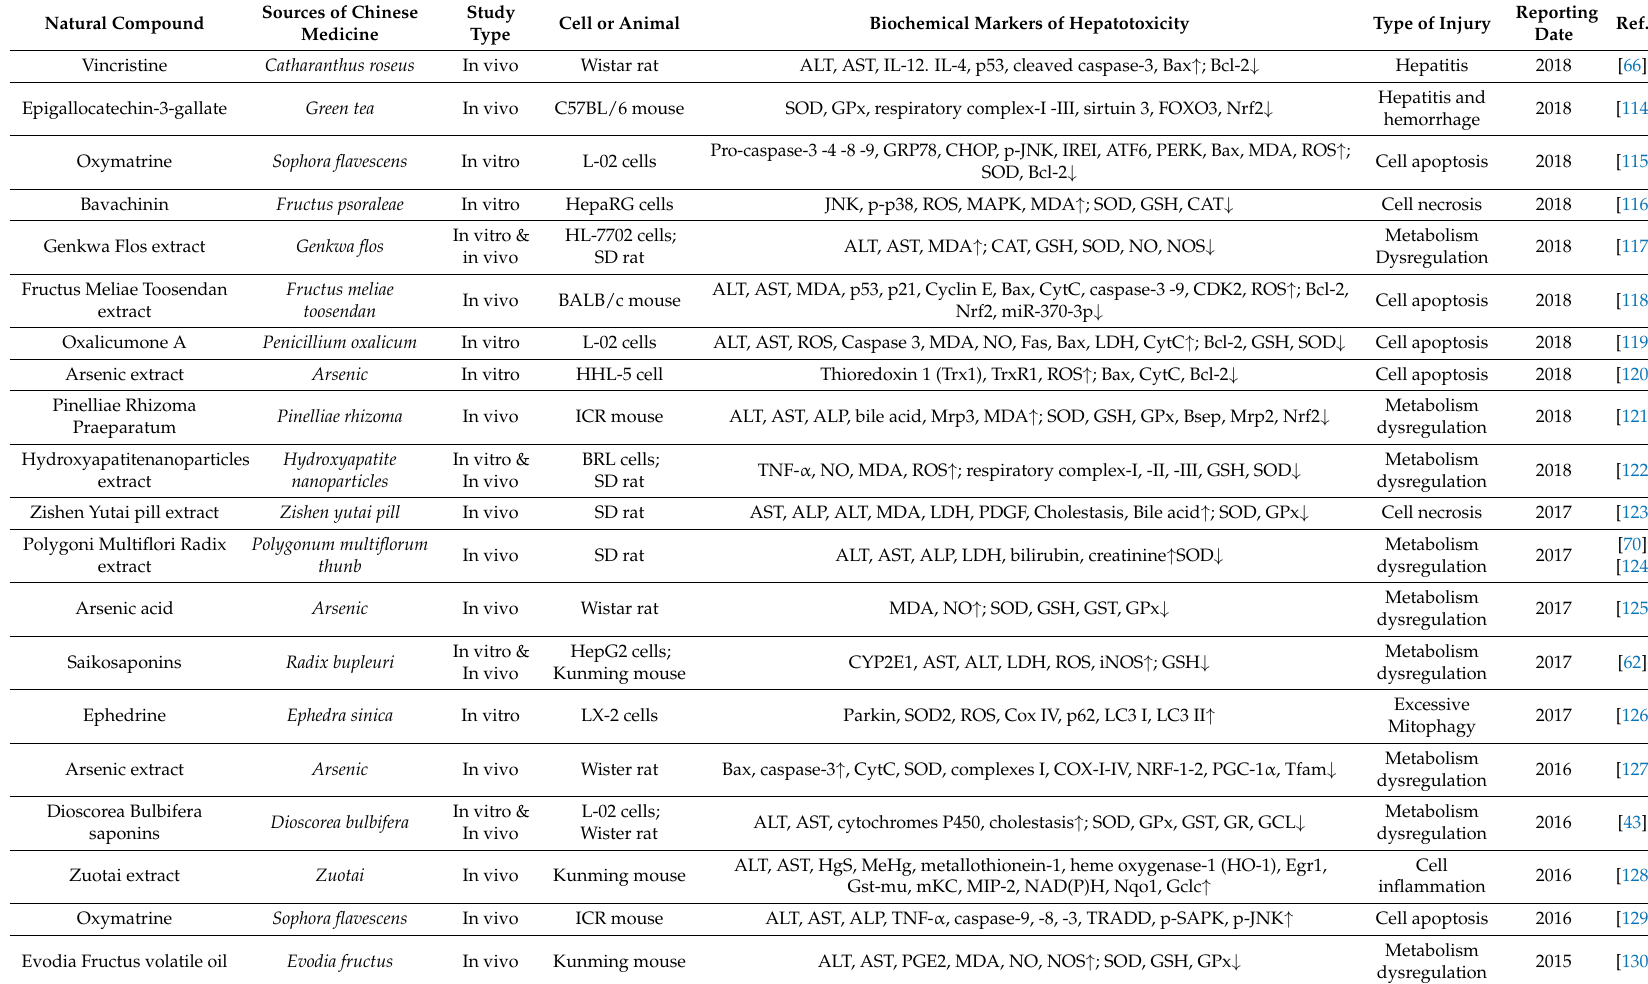
Table 1. Summary on the properties of TCM-induced hepatotoxicity in the recent 5